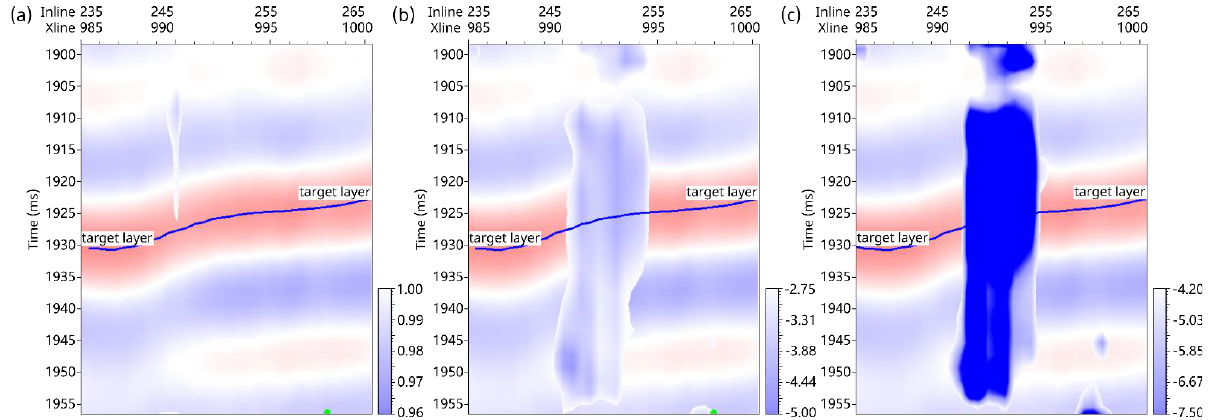
Figure 6. Different attributes crossed line 2. ( a ) Amplitude vs. coherence, ( b ) amplitude vs. PC , ( c ) amplitude vs. PC (new method).